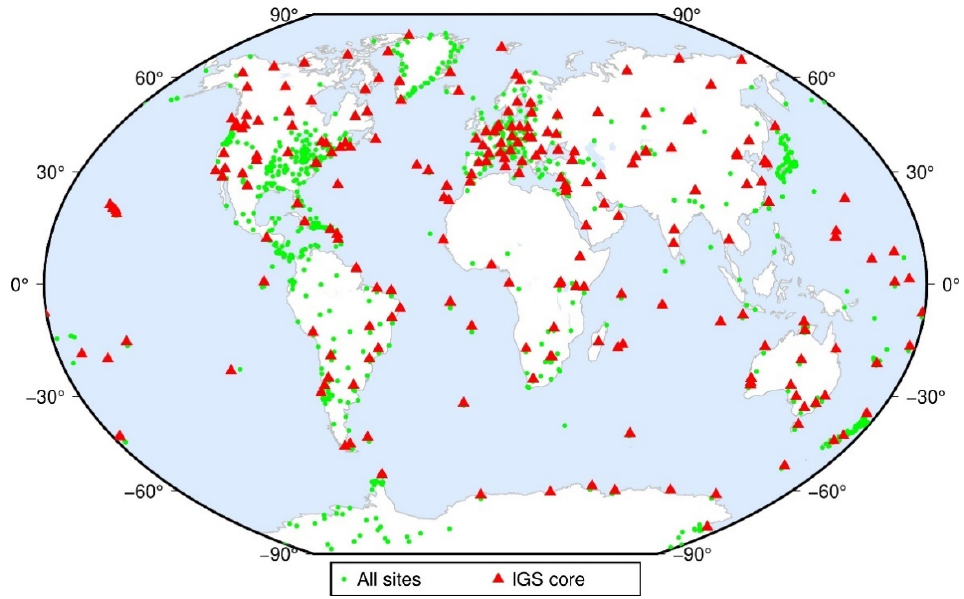
Figure 1. Distribution of global GNSS CORS network.